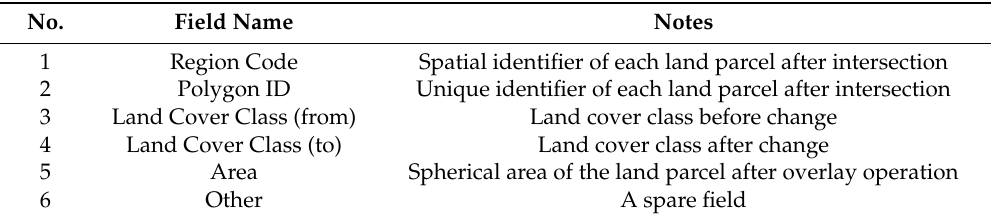
Table 1. Structure of the results for area calculation.